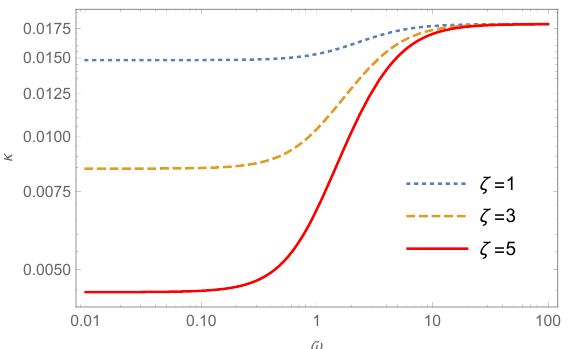
Figure 10 . The dependence of the transition rate of the Hawking-Page phase transition from the large SAdS black hole state to the thermal AdS state on the oscllating frequency ˜ ω for the oscillatory friction kernel. In the plot, L = 1 , T = 0 . 5 , and γ = 1